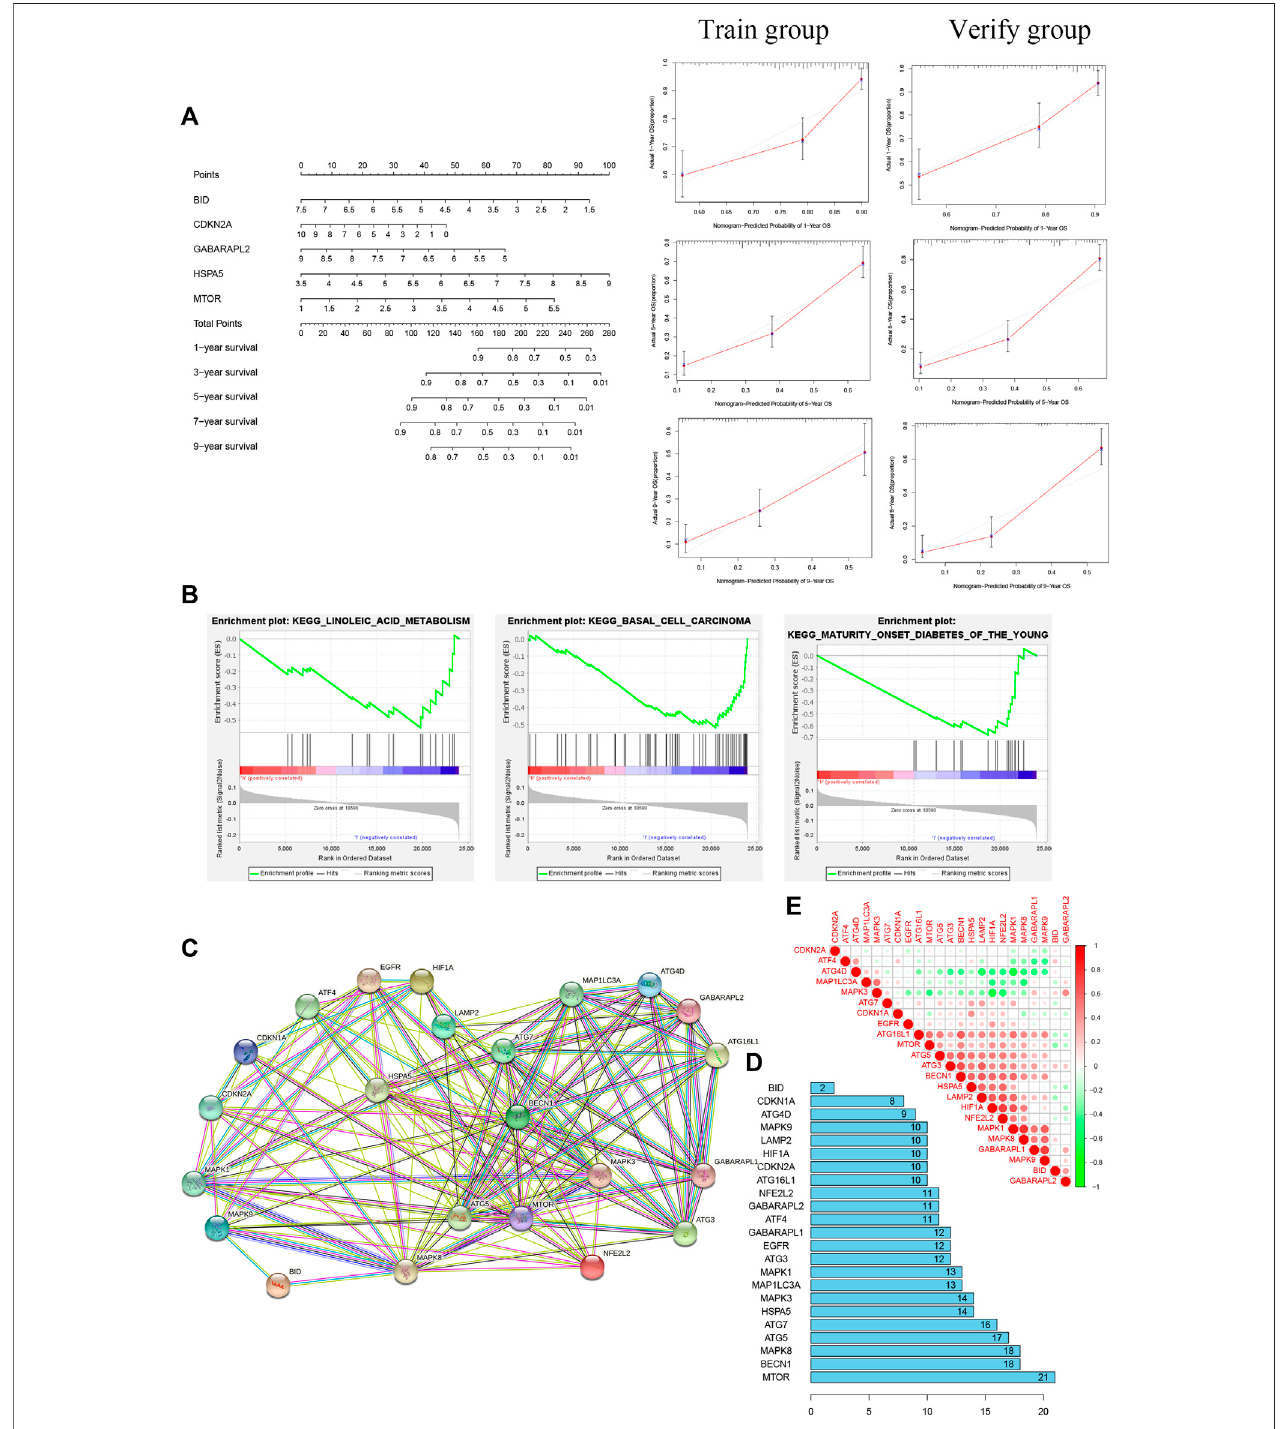
FIGURE6 |(A) Nomogram based on fi ve prognosis-related genes(left)and calibration curvesfor 1,5, and 9 years (right). (B) The main pathway enrichments were inbasalcellcarcinoma,linoleicacidmetabolism,andmature-onsetdiabetesoftheyoung. (C,D) Protein-proteininteractionnetworksuggestingthat MTOR hasthemost extensive links. (E) Positive and negative correlations among 23 autophagy-ferroptosis genes.